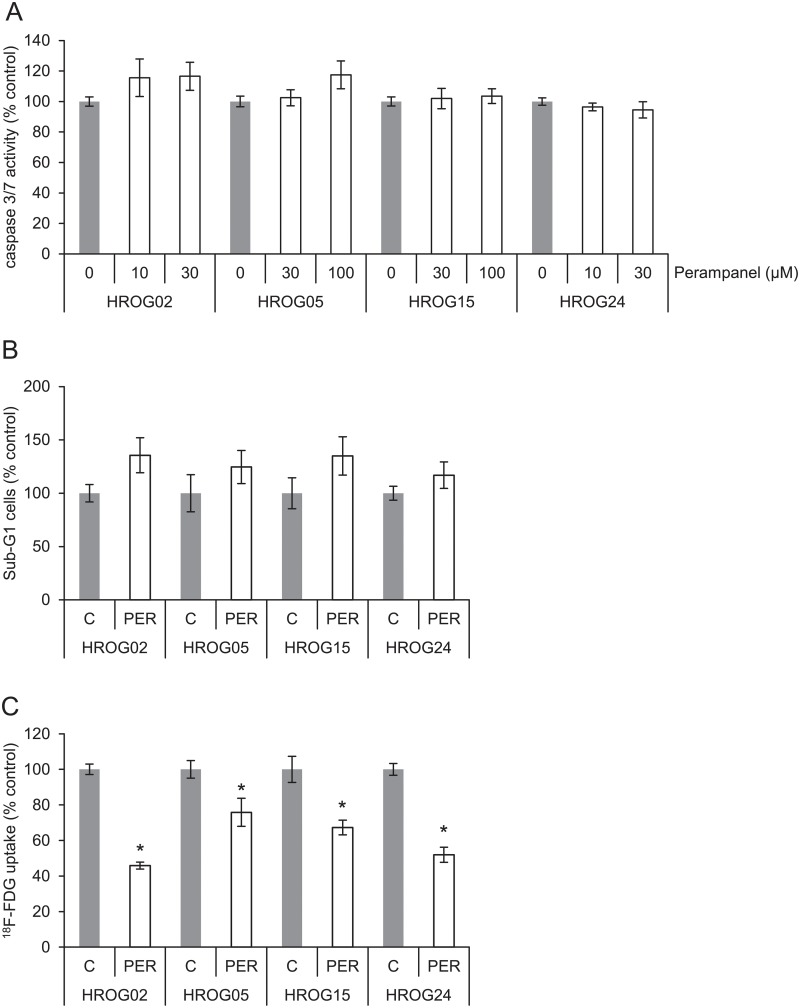
Cell death, caspase activation, and FDG uptake.(A) Subconfluent-growing glioblastoma cells were challenged with PER or solvent control DMSO, and caspase 3/7 enzyme activity was determined employing a colorimetric kit. Data are presented as mean ± SEM (n = 7–8 separate cultures). No significant caspase activation was observed (Kruskal-Wallis test with post hoc Dunn’s test). (B) Glioblastoma cells were exposed to highest dose of PER from caspase activation analysis for 48 h and of apoptotic (Sub-G1 peak) cells were estimated by cytofluorometric quantification. The portion of dead/apoptotic cells is expressed as percent of solvent treated control cultures. Data from n ≥ 5 separate cultures were used to calculate mean values ± SEM. No significant change in Sub-G1 fraction was observed (Mann-Whitney U test). (C) Glioblastoma cells were labelled with 18F-FDG, and tracer uptake was quantified. Counts per minute were normalized to the protein content of the samples. One hundred percent 18F-FDG uptake corresponds to solvent-treated tumor cells (n = 9; mean values ± SEM); *p<0.05 versus control cultures (Mann-Whitney U test).